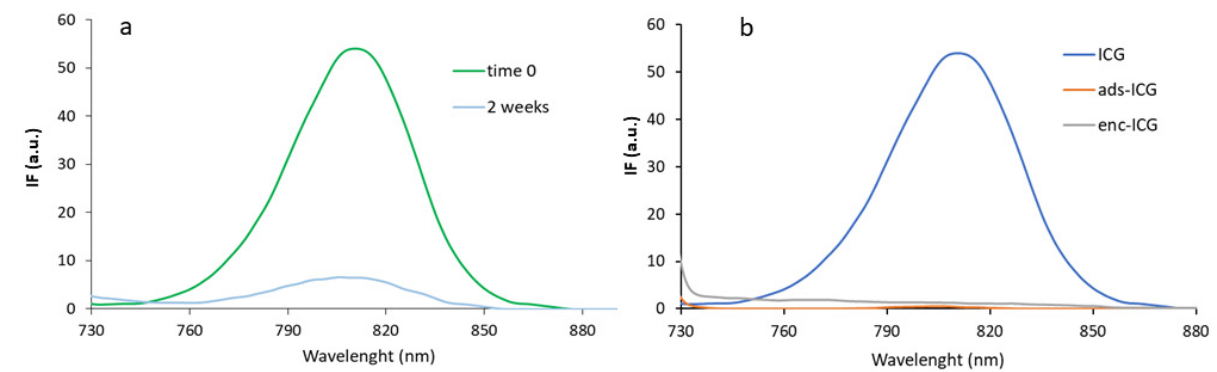
Figure 4. Fluorescence spectra of ICG in aqueous solution at time zero and after 2 weeks at 4 °C ( a ), and of ICG in aqueous solution (ICG, repeated for comparison) and associated with NPs (ads-ICG and enc-ICG) at time zero ( b ).